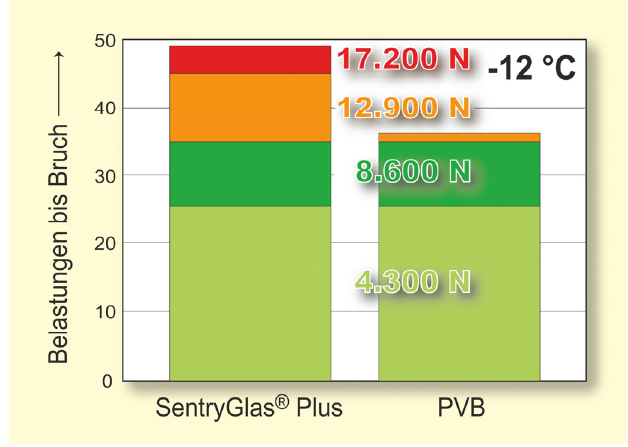
Figure 5: Comparison of impact resistance of laminates made with SentryGlas® and PVB